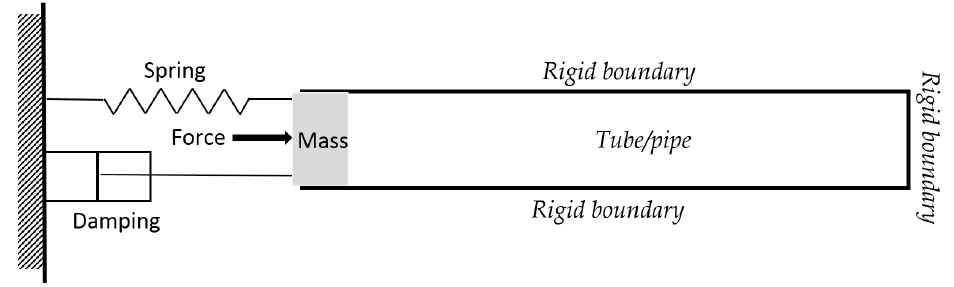
Figure 1. The linear structural–acoustic model in [1].